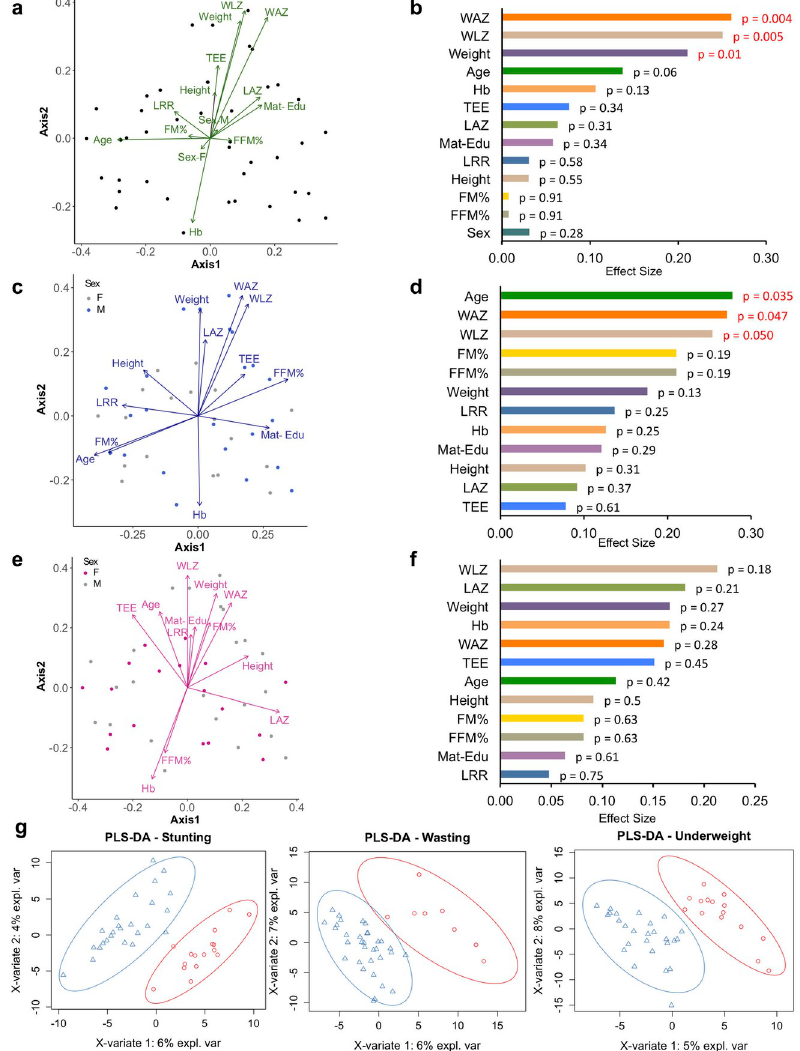
Fig 1. Microbial community variation among 18–24 month old Indian children. Microbial community variation represented by Principal coordinates analysis (PCoA) based on Bray-Curtis distances highlighting the covariate contribution to community variation estimated using envfit correlation analysis plotted against first two components with arrows scaled to contribution in (A) all 41 participants, (C) boys (n = 23) and (E) girls (n = 18). Effect sizes of covariates of microbial composition in (B) all 41 participants, (D) boys (n = 23) and (F) girls (n = 18), significance indicated with p-values (p < 0.05). (G) PLS-DA score plot showing model discrimination between cases and non-cases with respect to stunting, wasting and underweight status, respectively. The ellipses denote 95% confidence intervals for each grouping. LAZ: length-for-age Z-score, WAZ: weight-for-age Z-score, WLZ: weight-for-length Z-score, TEE: total energy expenditure, LRR: lactulose to rhamnose ratio, FM: fat mass, FFM: fat free mass.